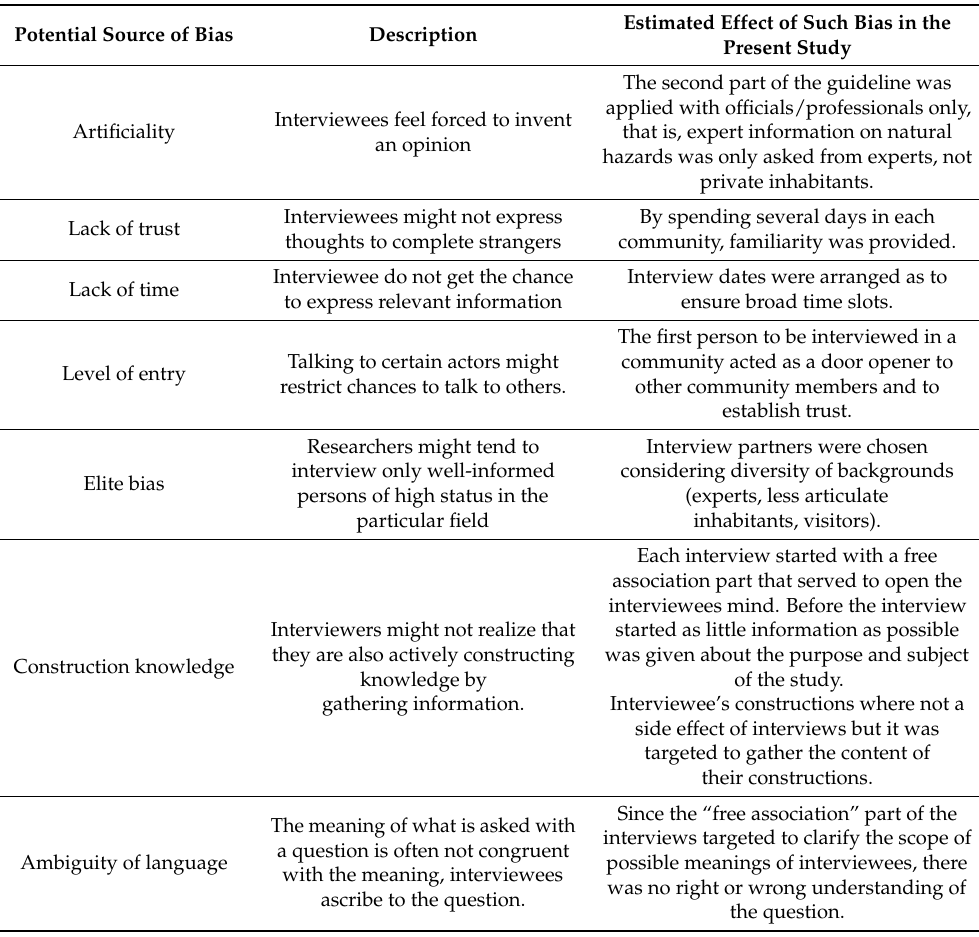
Table 2. Potential bias in